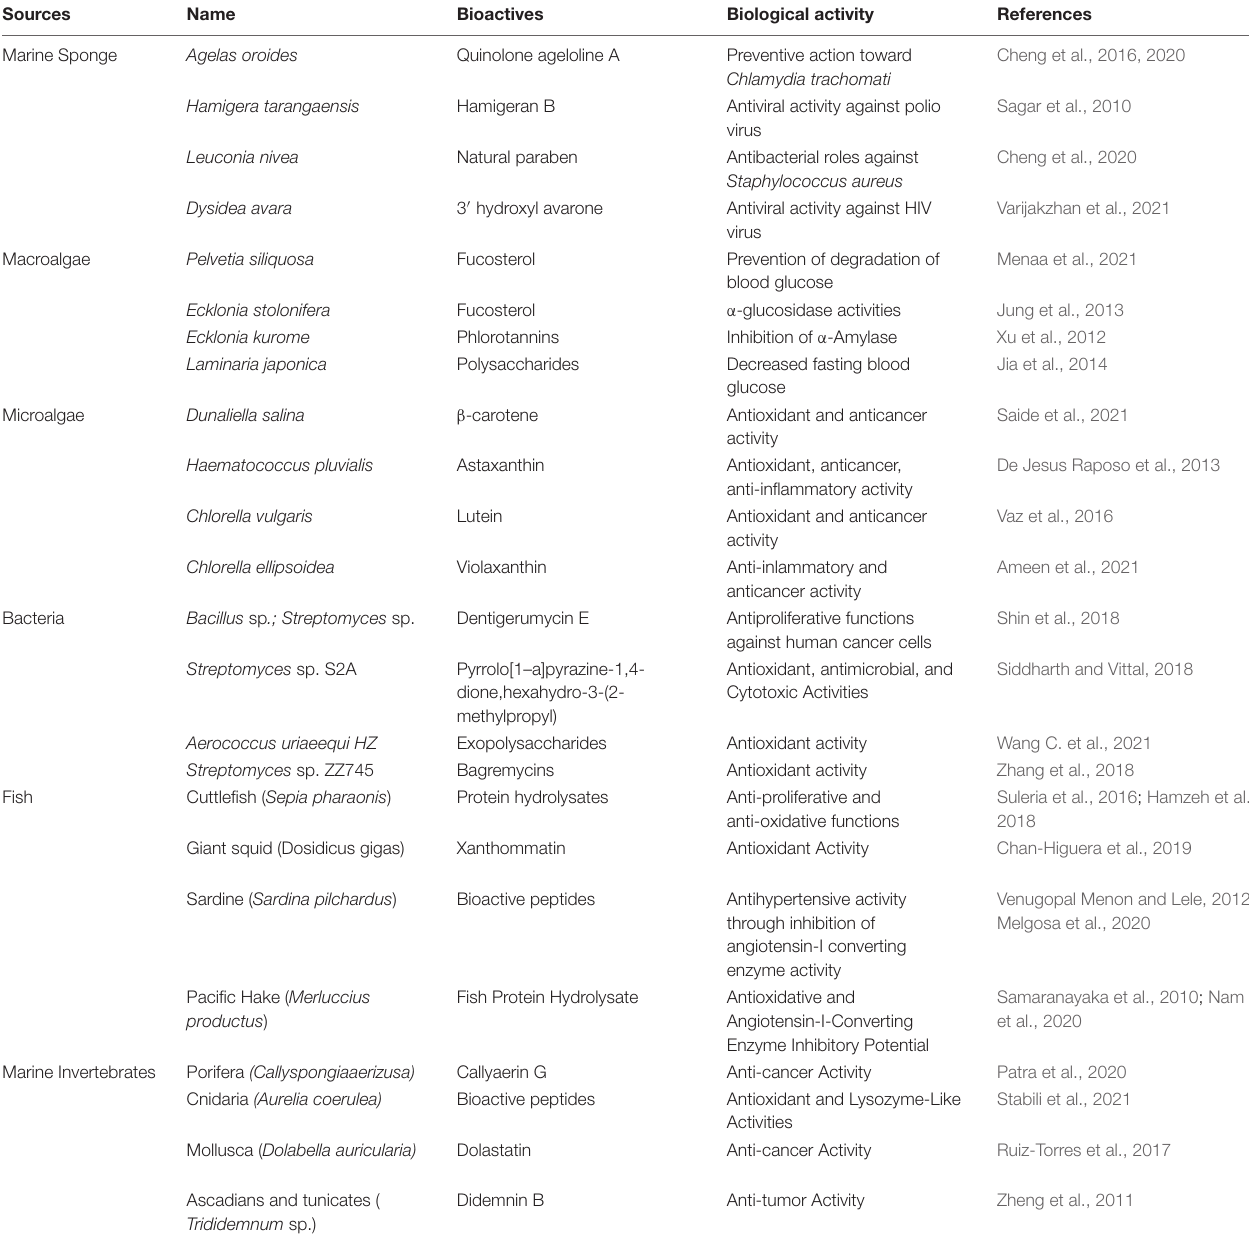
TABLE 4 | Bioactives from marine sources and their potential health